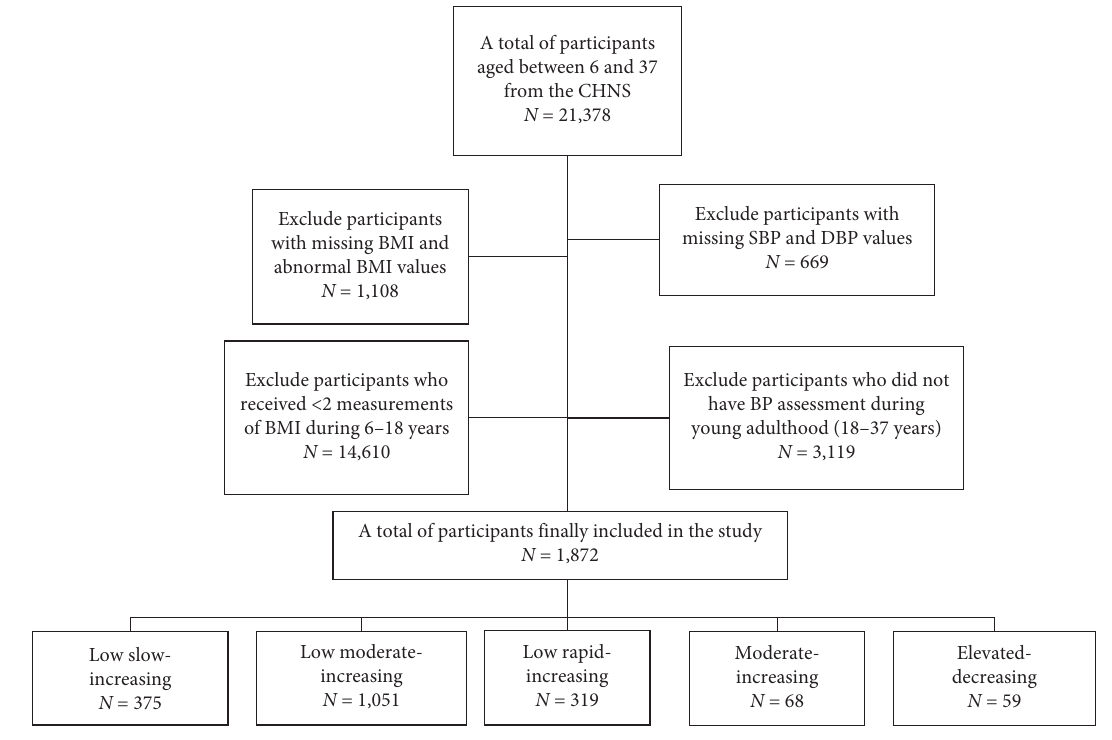
Figure 1: Flow chart for selection process of the